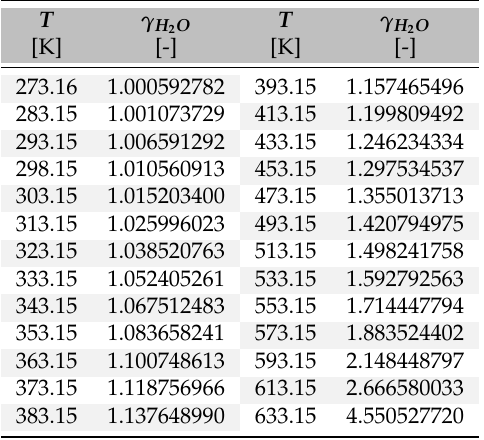
Table A1. The ratio of specific heats of water.